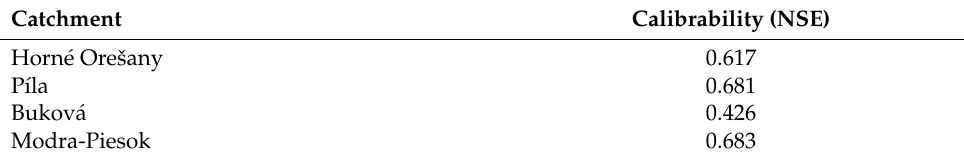
Table 5. Calibrability of the